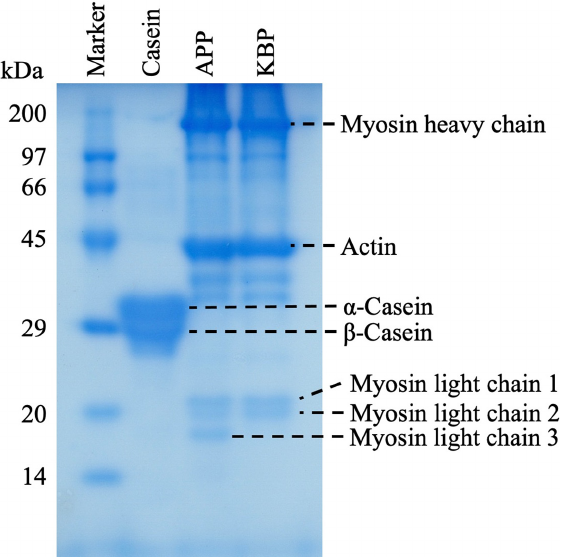
Figure 1. Sodium dodecyl sulfate-polyacrylamide gel electrophoresis (SDS-PAGE) analysis of casein, APP, and KBP band patterns. SDS-PAGE was performed using a 12.5% polyacrylamide separation gel. APP, Alaska pollock protein; KBP, kamaboko protein.